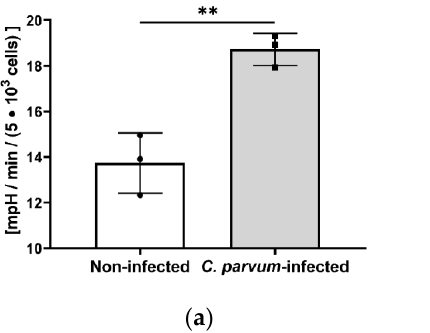
Figure 4. Glucose, lactate, pyruvate, aspartate, glutamine, glutamate, alanine and serine conversion rates in uninfected and C. parvum -infected HCT-8 cultivated in glutamine-starved medium (0.02 mM) at hyperoxia (21% O 2 ) and physioxia (5% O 2 ) ( n = 6, each group). In comparison to glutamine-supplemented cultivation conditions the parasite infection rate slightly dropped in glutamine starved medium (21% O 2 : 40 ± 3%; 5% O 2 : 28 ± 7%). Conversion rates were analysed at 48 h p. i. in the cell culture supernatants of the cells. Metabolic conversion rates are plotted as interleaved box and whiskers plots showing minimum to maximum values with line at the medians. Statistical significance (* = p ≤ 0.05, ** = p ≤ 0.01, *** = p ≤ 0.001, **** = p ≤ 0.0001) was determined by t -test for independent samples.